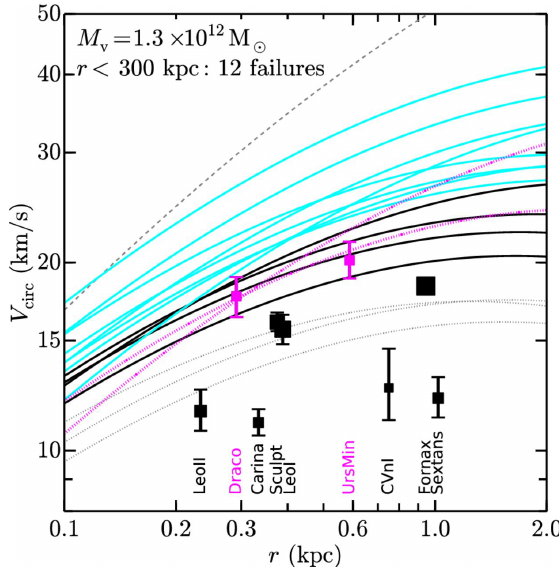
Figure 11. Circular velocity profiles of simulated dark-matter subhalos compared to measured velocity dispersions of Milky Way dSph satellites to illustrate the too-big-to-fail problem in the Milky Way